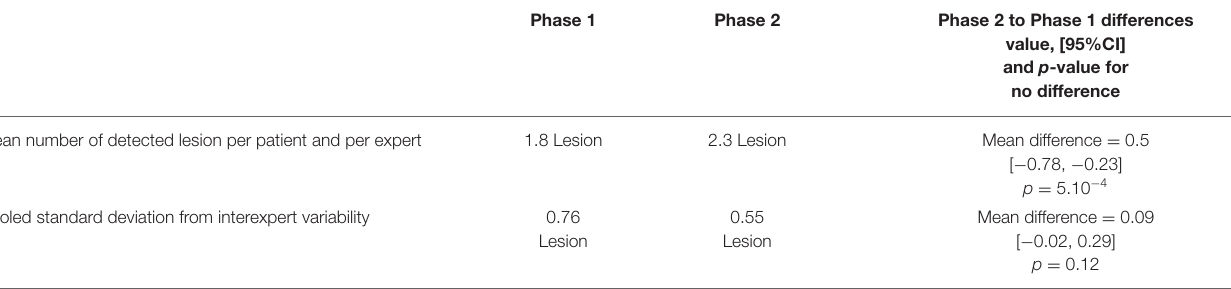
TABLE 5 | Statistics on lesion detections averaged over patients and differences between phase 1 (lesions detection only using patient acquisitions) and phase 2 (lesions detection using patient acquisitions and segmentation mask produced by the segmentation module).